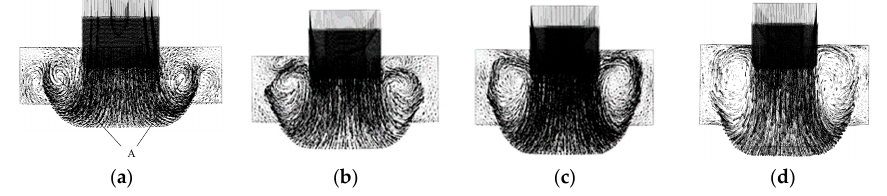
Figure 6. Instantaneous velocity field of cross section at different CA. ( a ) CA = 470° BTDC; ( b ) CA = 450° BTDC; ( c ) CA = 430° BTDC; ( d ) CA = 410° BTDC.